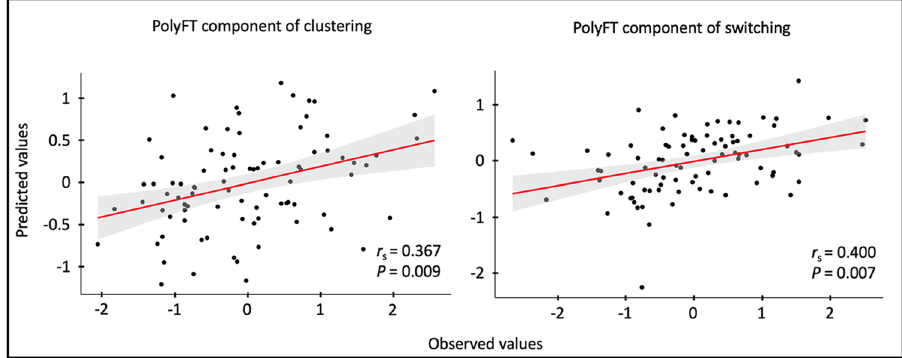
Fig. 3 Predicted and observed PolyFT components. The plots show the Spearman correlations between the predicted values ( y axis) and observed values ( x axis) of the clustering and switching components based on brain connectivity for the signi fi cant predictions ( n = 86). The fi tting regression line is shown in red, and the 95% con fi dence interval for the line is shown in gray shading. For each plot, we present the r s and the P values. The reported P values are based on permutation